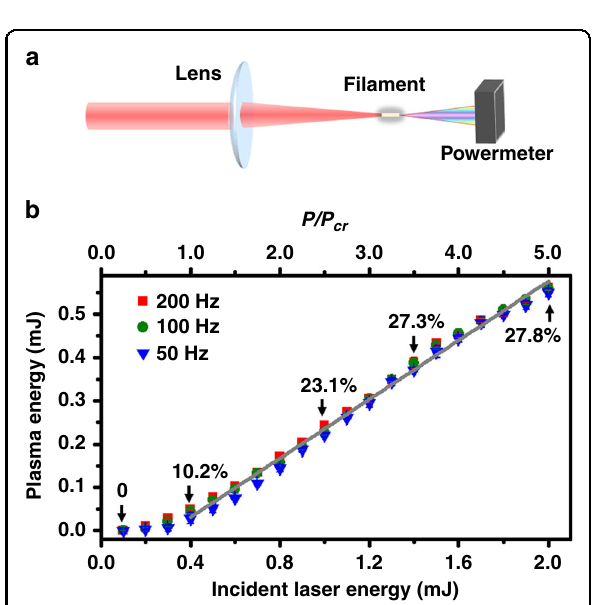
Fig. 4 Energy deposition measurement. a Schematic of the experimental setup for measuring energy deposition. b Plasma energy couplings in the premixed methane – air fl ow measured with laser repetition rates of 50 (blue triangle), 100 (green circle), and 200 Hz (red